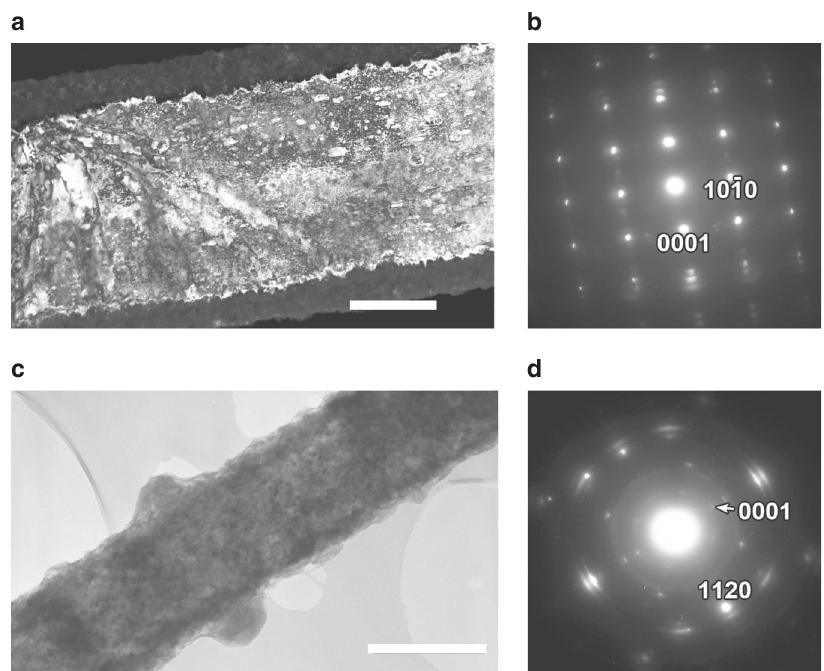
Fig. 2 Transmission electron microscopic (TEM) images and selected area electron diffraction (SAED) patterns of type I and type II fi bres. a High- magni fi cation dark- fi eld TEM image of a type I fi bre (Li 3 N core and an LiOH outer layer) and b corresponding SAED pattern in the <1210> projection demonstrating the <1010> nano fi bre growth direction; c bright- fi eld TEM image of a type II fi bre and d corresponding SAED pattern in the <0110> projection (with arcs due to an LiOH surface layer) showing the <0001> growth direction. Scale bars in a and c correspond to 500 nm.